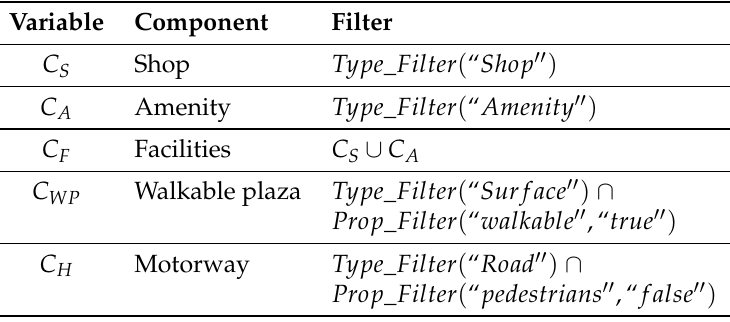
Table A2. Set of components associated with a shopping